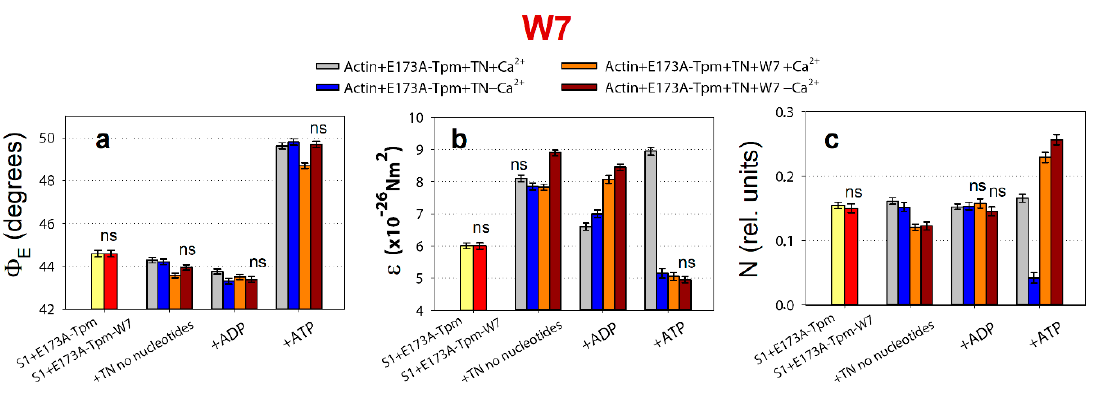
Figure 8. The effect of troponin and Ca 2+ on the values of Φ E ( a ), ɛ ( b ) and N ( c ) of the polarized fluorescence of 1,5-IAEDANS bound to S1 (AEDANS-S1), in the presence of the E173A-Tpm or E173A-Tpm with 50 μ M of W7 revealed in glycerol-skinned fibres under conditions simulating the sequential steps of the actomyosin ATPase cycle. The data represent the mean values for 5–7 fibres for each experimental condition. The Φ E , ɛ and N values in the presence of troponin are significantly altered by W7 ( p < 0.05). Statistically insignificant differences in the values of Φ E , ɛ and N between the WT and mutant Tpms are indicated by the symbol “ns”. Error bars indicate ±SEM.